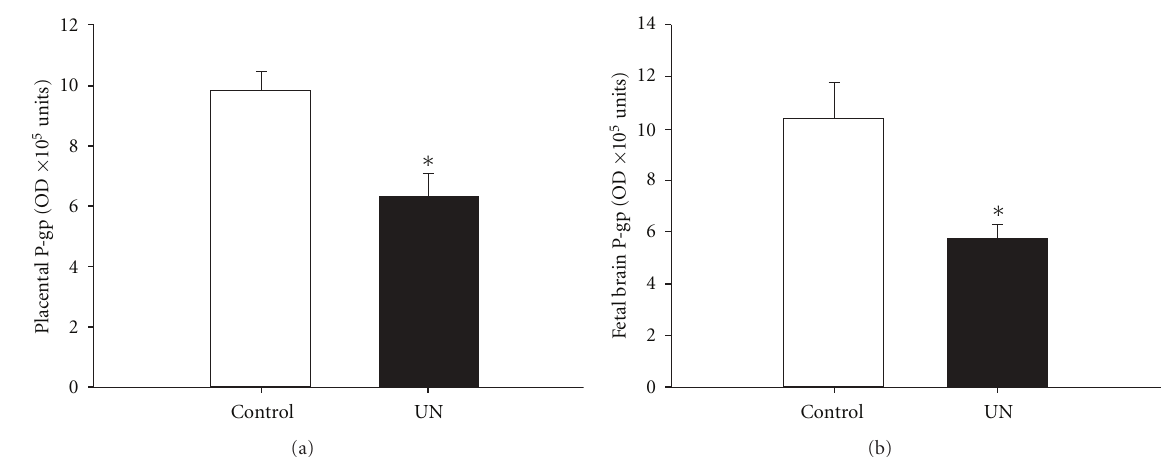
Figure 1: Placental (a) and fetal brain (b) P-gp protein expression in control (open bar, n = 6) and maternal undernutrition (UN; filled bar, n = 7) at 60–62 days of gestation (term, 69 days) in the guinea pig. P-gp expression (mean ± SEM) was quantified by Western blotting with monoclonal C219 antibody. There was less P-gp protein in the UN placenta and fetal brain than in controls. ∗ P < 0 . 05. The figure is reproduced with permission from [92].